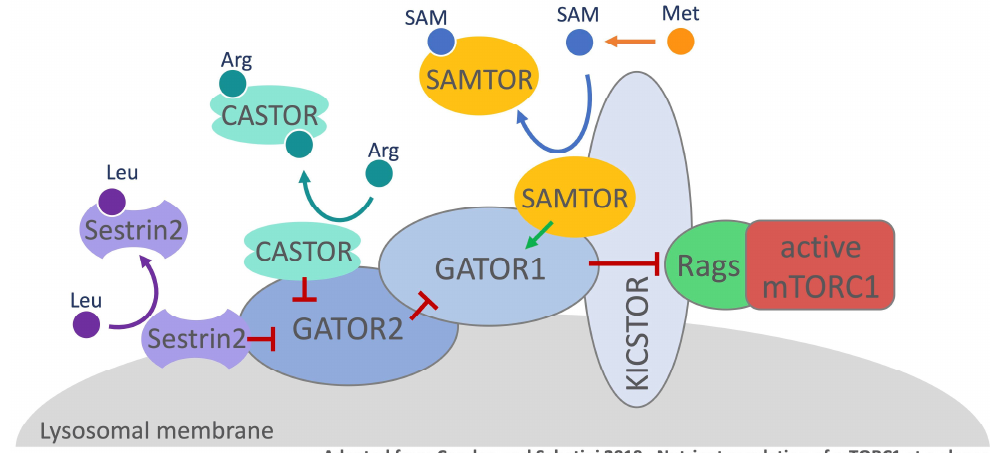
Figure 4. Amino acid perception in mammalian cells via mTORC1. For simplicity, only the components that are mentioned in this paragraph are shown in the model. mTORC1 (mechanistic Target of Rapamycin Complex 1), Rags (Rag GTPases), KICSTOR (KPTN-, ITFG2-, C12orf66-, and SZT2-containing regulator of TOR), GATOR1 (GAP activity towards the Rags 1), GATOR2 (GAP activity towards the Rags 2), CASTOR (Cellular Arginine sensor for mTORC1), SAMTOR (S-adenosylmethionine sensor upstream of mTORC1). mTORC1 activity coordinates availability of nutrients with cell growth. Certain amino acids are sensed in the cell and their abundance regulates mTORC1 activity. Leucine binds to its sensor Sestrin2, which leads to Sestrin2 dissociation from GATOR2. Leucine-starvation benefits the interaction of Sestrin2 and GATOR2 promoting the inhibition of mTORC1. CASTOR operates in a similar fashion, however binds 2 molecules of the amino acid arginine. During arginine starvation, CASTOR interacts with and inhibits GATOR2 resulting in subsequent mTORC1 inhibition. Methionine is rapidly converted into SAM and SAMTOR binds the metabolite. In the absence of SAM, SAMTOR interacts with KICSTOR and GATOR1 to inhibit mTORC1 signaling.